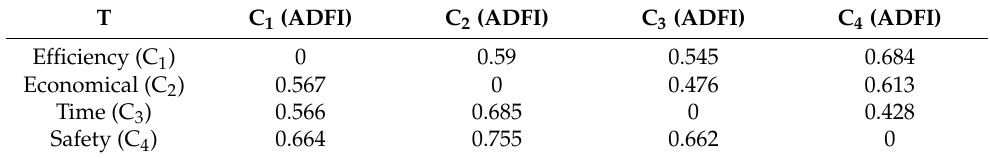
Table 5. Average direct fuzzy influence matrix T between BPM tool selection main criterions. T